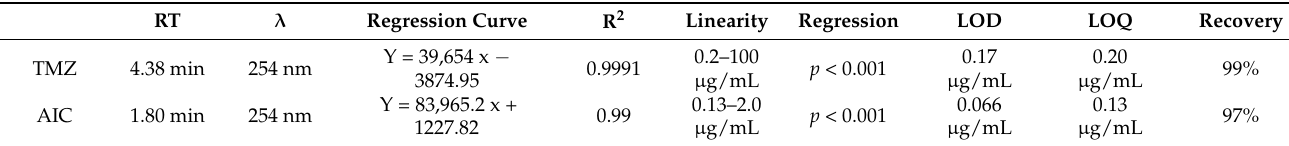
Table 2. TMZ and AIC assay method and validation